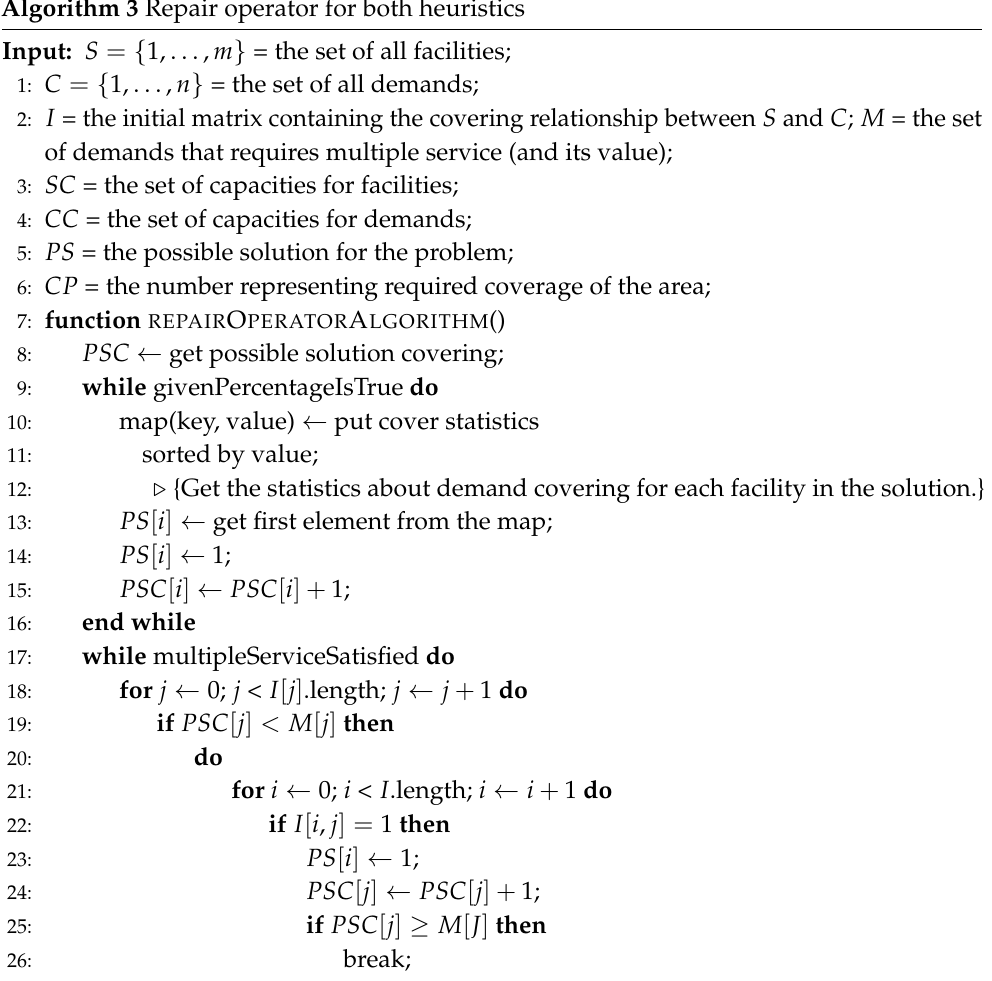
Algorithm 3 Repair operator for both